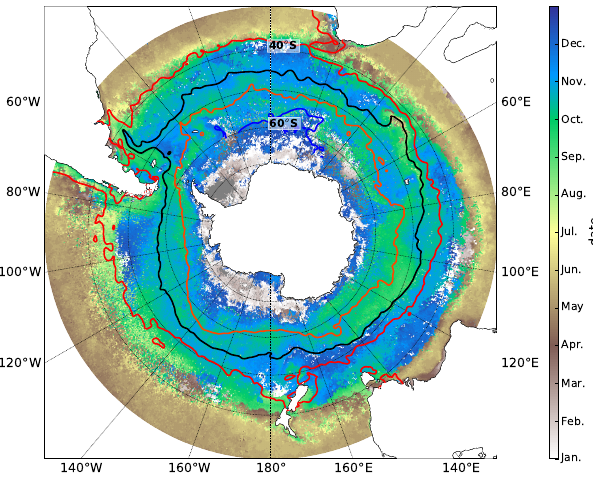
Fig. 2. Date of the phytoplankton bloom initiation in the South- ern Ocean south of 30 ◦ S. Mean (1998–2007) frontal positions cal- culated from MADT contours shown for the STF (red), the SAF (black), the PF (orange) and the SACCF